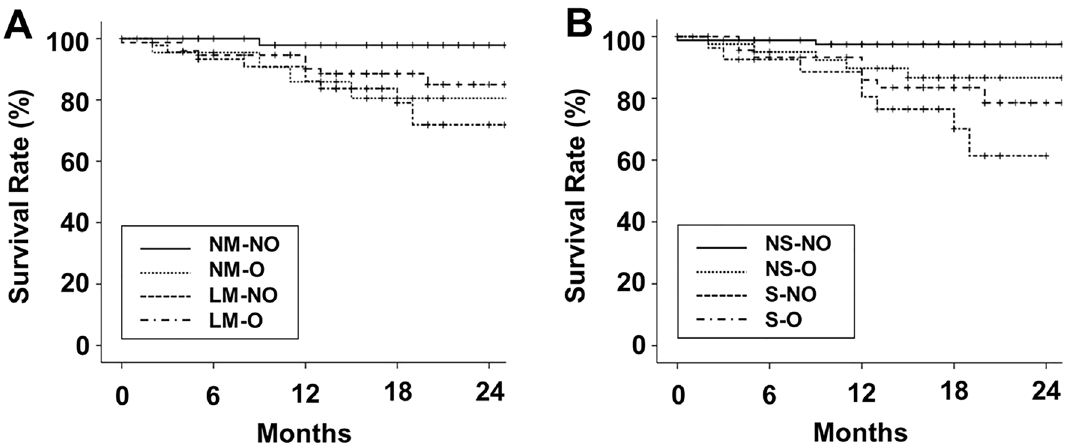
Figure 3. Kaplan–Meier curves of patient survival according to ALM index or sarcopenia. ( A ) The 18-month survival rates in NM-NO, NM-O, LM-NO, and LM-O groups were 97.9%, 80.5%, 88.6%, and 79.1%, respectively ( P = 0.118). LM-O vs NM-NO or LM-NO, P < 0.05; Other comparisons, P > 0.100. ( B ) The 18-month survival rates in NS-NO, NS-O, S-NO, and S-O group were 97.5%, 86.6%, 83.5%, and 70.1%, respectively ( P = 0.003). NS-NO vs S-O or S-NO, P < 0.05; Other comparisons, P >